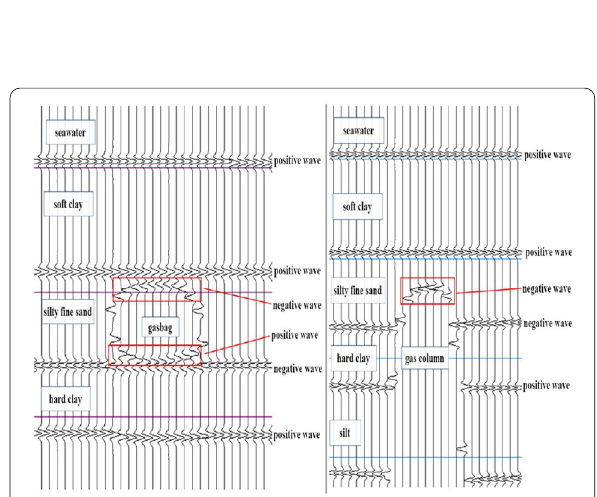
Fig. 4 Partial reflective wave at the top of the shallow gas in the forward formation